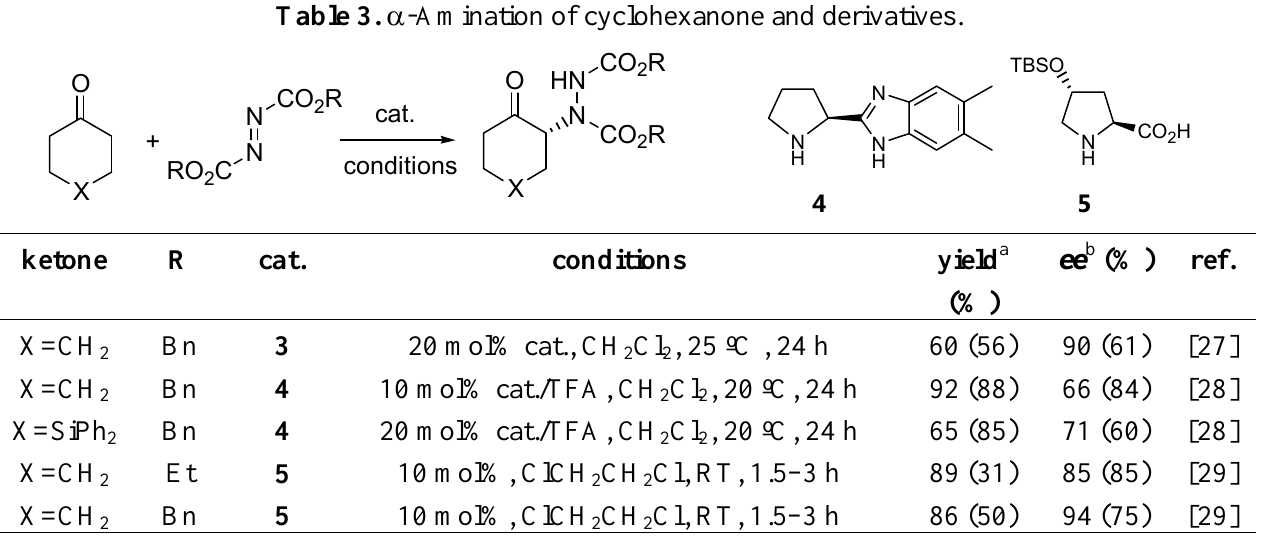
Table 3.  -Amination of cyclohexanone and